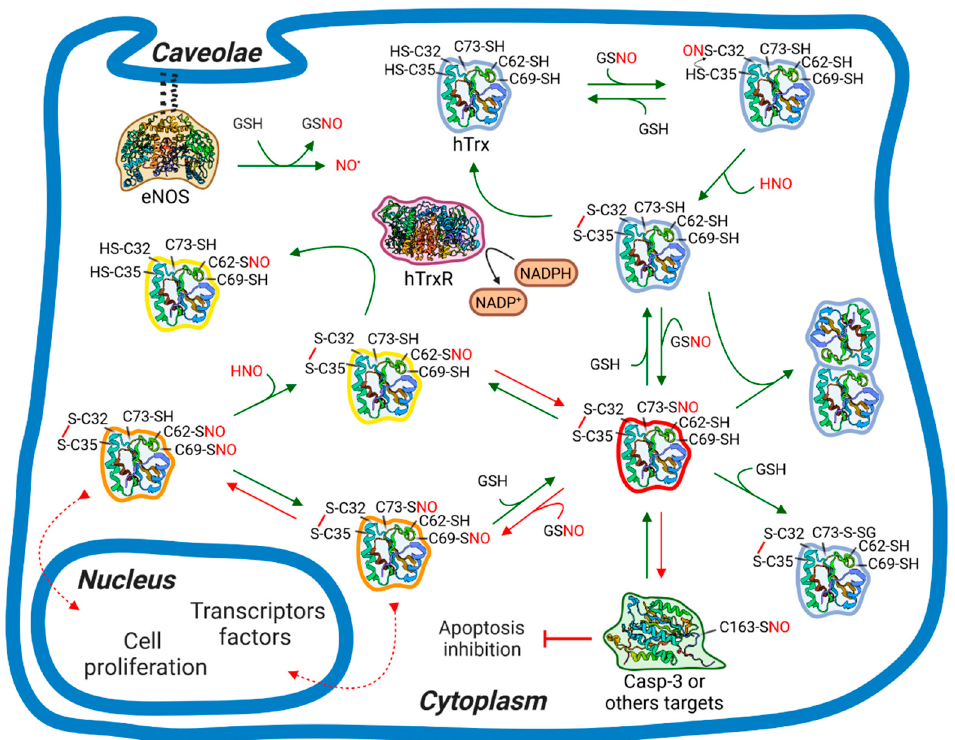
Figure 8. Hypothetical S-nitrosation path for hTrx based on the present findings and literature data: S-nitrosation of hTrx in a cell context. In the cell, eNOS produces NO that promptly reacts with GSH forming GSNO, responsible for transnitrosate C32 of reduced hTrx. Cys35 acts as a nucleophile and attacks C32-SNO to form a disulfide bond, leading to the oxidized form of hTrx. Reduced hTrx can be restored by NADPH-dependent hTrxR. After the oxidation of the hTrx redox site, the second step is the S-nitrosation of C73, the most solvent-exposed and reactive Cys residue. The S-nitrosation of C73 promotes the S-nitrosation of C62, the storage site, by a reversible NO internal transfer. Note that this mechanism regulates C73-SNO availability resulting in a control of Casp-3 S-nitrosation promoted by C73-SNO. Under nitrosative stress, GSNO also transnitrosate C69, a NO signaling pathway involved in hTrx translocation to the nucleus. C62 S-nitrosation exerts a cooperative effect in C69-SNO, leading to S-denitrosation of C69 residue and regulating the hTrx translocation to the nucleus. C73-SNO is also prone to thiolation reactions, such as hTrx dimerization and glutathionylation. The species are colored according to their reactivity, with blue as neutral or non-S-nitrosated, yellow, orange, and red with increasing S-nitrosation reactivity. Green arrows represent a physiological condition, whereas red arrows, nitrosative stress. hTrx, hTrxR, Casp-3 and eNOS are represented by PDB 4TRX [62], 2J3N [63], 1GFW [64], and 3NOS [65], respectively. Cys residue’s position is merely illustrative. Created with BioRender.com (accessed on 17 April